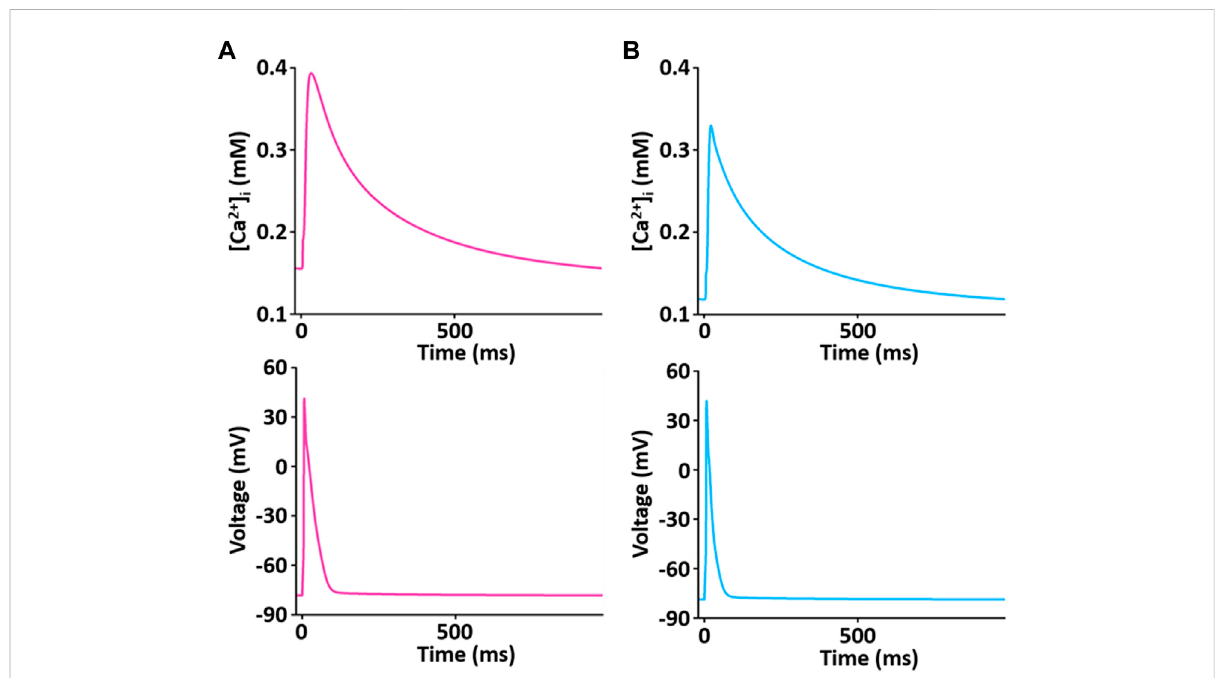
FIGURE 11 SimulatedCa 2+ transienttraceshows theunderlying changesin[Ca 2+ ] i during correspondingAPdurationfor LV (A) andRV (B) myocytes at1 Hz and 22 ° C (Kim, 2018).